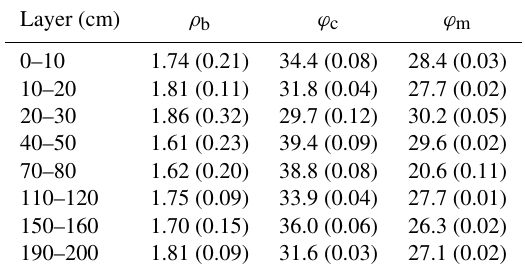
Table 1. The mean (standard deviation in brackets) of measured soil bulk density ( ρ b , gcm − 3 ) , porosity calculated from bulk density ( ϕ c , m 3 mm − 3 ) , and measured porosity ( ϕ m , m 3 m − 3 ) of different layers based on soil samples in this